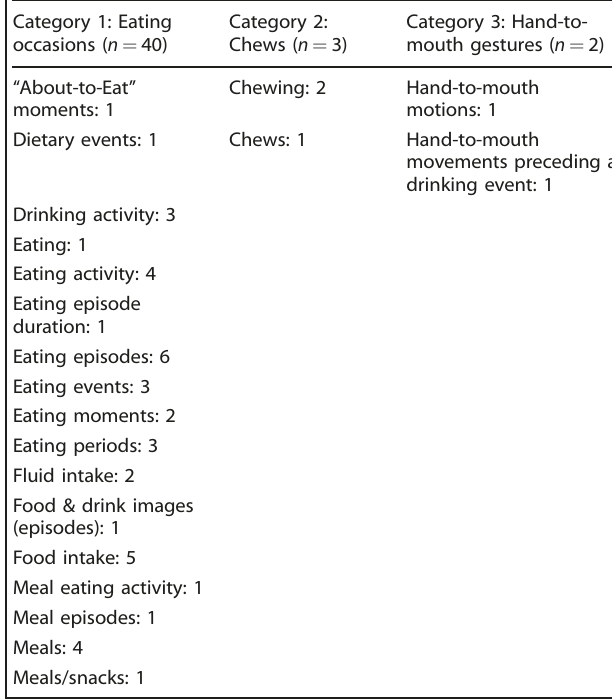
Table 3. Reported eating outcomes ( n = 45) from included studies, by